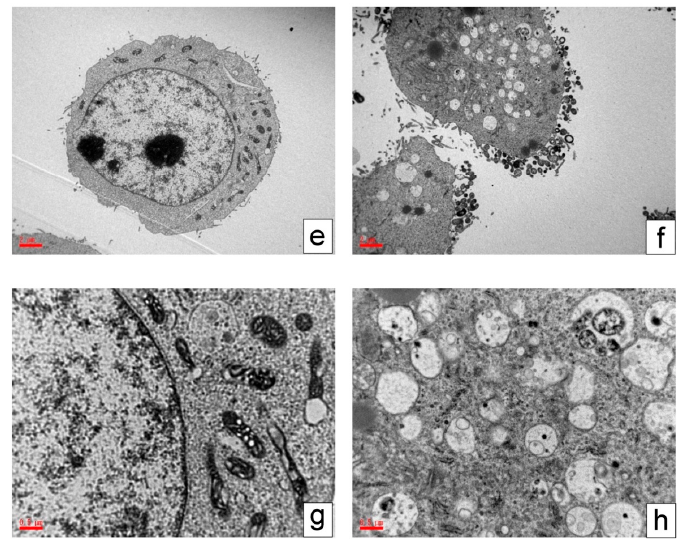
Figure 3. Morphology changes in CT26 cells. Left panels: CT26 cells without treatment Right panels: CT26 cells treated with 10mg/mL DBT-PD for 72h. ( a , b ) CT26 cells; ( c , d ) HT-29 cells were stained with Liu’s stain and photographed under a light microscope; ( e – h ) TEM microphotographs showing the ultrastructure of CT26 cells. Magnification 10,000- and 20,000-fold. 2.7. Enhancement of 5-Fluorouracil (5-FU) Effect by DBT-PD Concurrent treatment of CT26 cells with DBT-PD and low concentrations of 5-fluorouracil (5-FU) markedly inhibited cell growth compared to that with DBT-PD or 5-FU alone (Table 4). It is noteworthy that DBT-PD markedly enhanced the growth inhibitory effect of 0.1 and 0.5 µM 5-FU than that of 1.0 µM 5-FU alone. The combination indices (CI) were calculated using CompuSyn